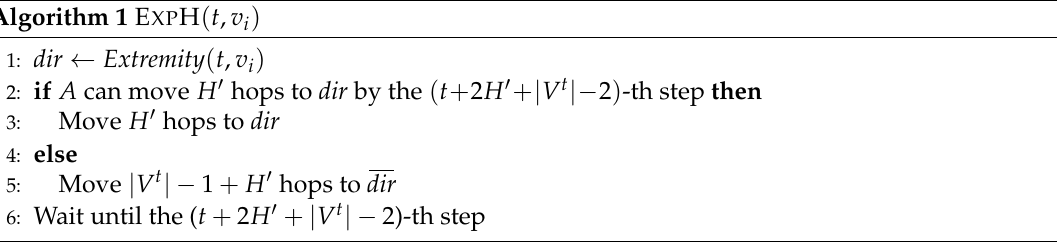
Algorithm 1 E XP H ( t , v i